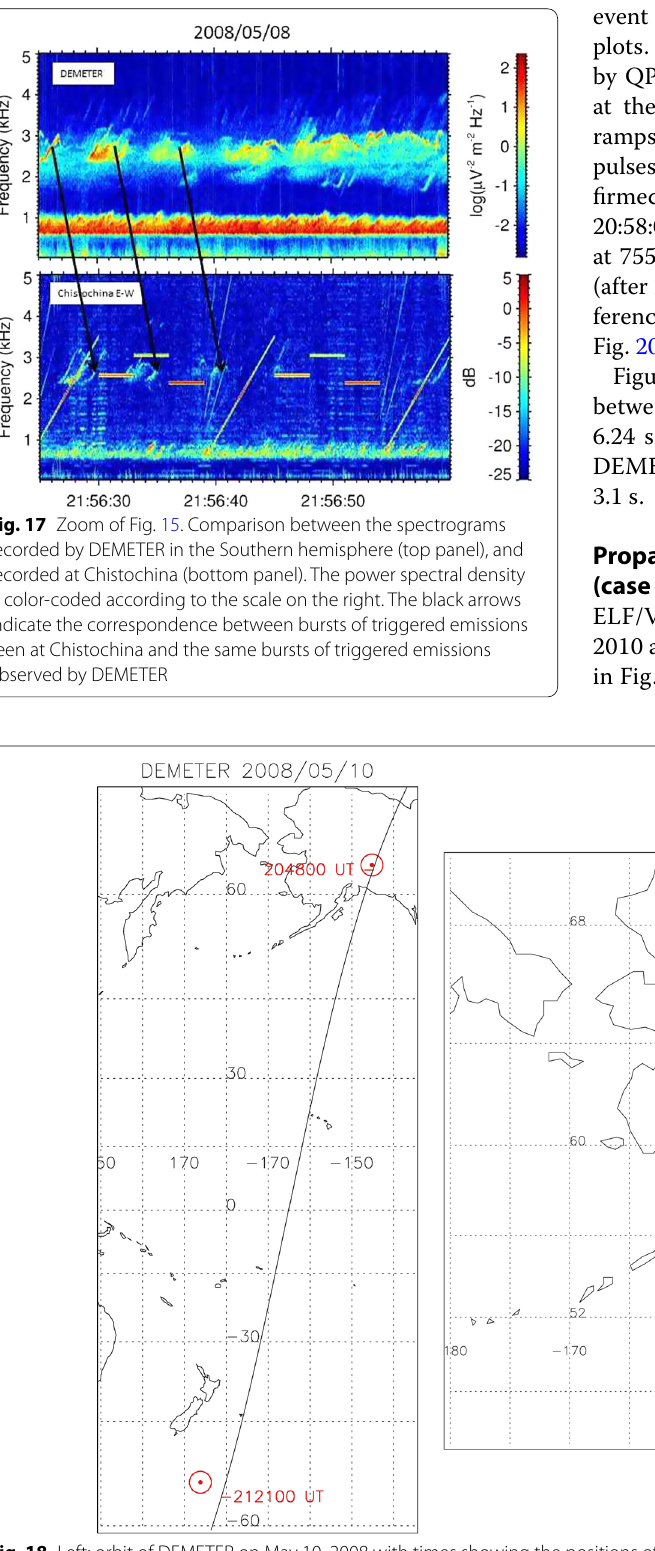
Fig. 18 Left: orbit of DEMETER on May 10, 2008 with times showing the positions of HAARP and its conjugate point. Right: zoom in the Northern hemisphere showing the positions of the ground receivers at Chistochina and